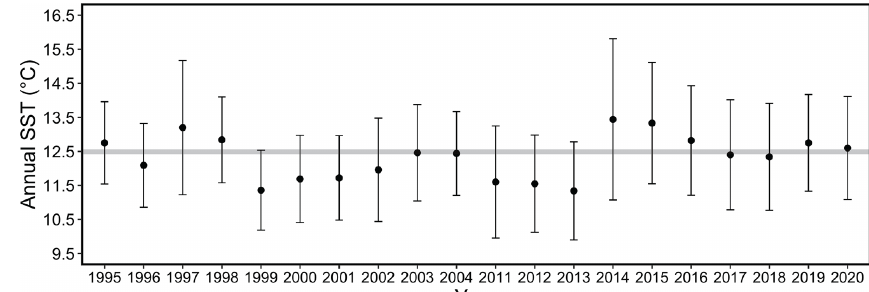
Figure 9. Mean annual SST for each year of the study period. Error bars represent the standard deviation of daily temperatures over the course of each year. Shaded bar plotted at 12.5 ◦ C for ease of visual comparison across annual means from 1995 to 2004 and 2011 to